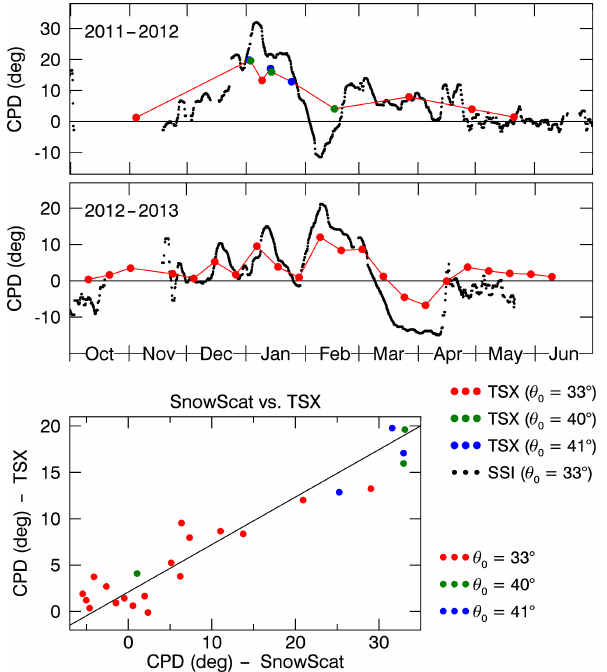
Figure 18. CPD measured by TerraSAR-X (TSX) at θ = 33, 40, and 41 ◦ compared to SnowScat (SSI) measurements ( f = 9.65GHz, in- terpolated to θ = 33 ◦ ). Both instruments show the same trend (top panel) but the CPD measurements of the SSI are about a factor of two larger than the TSX measurements (bottom panel). The discrep- ancy can be explained by different snow conditions as the TSX data were acquired over large open areas where about 30% less snow depth was measured compared to the test site of the SSI.